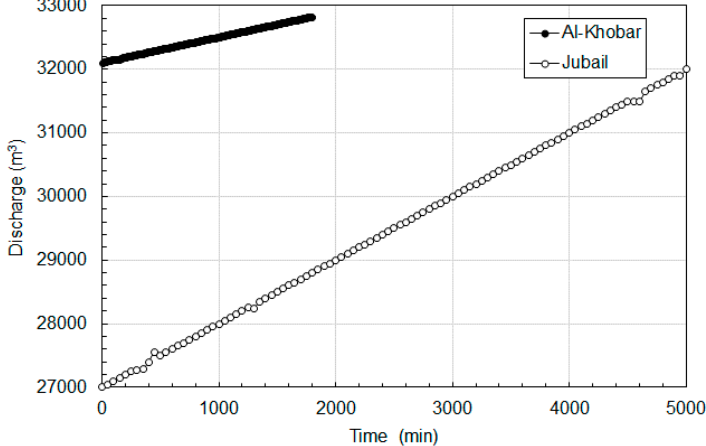
Figure 6. Discharge from the beach wells vs. time for the Al-Khobar and Jubail sites.